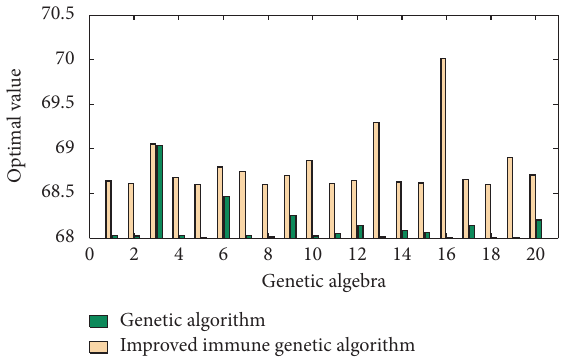
Figure 10: Simulation diagram of clustering prediction solution for logistics network problem of single-period remanufacturing supply chain under option contract